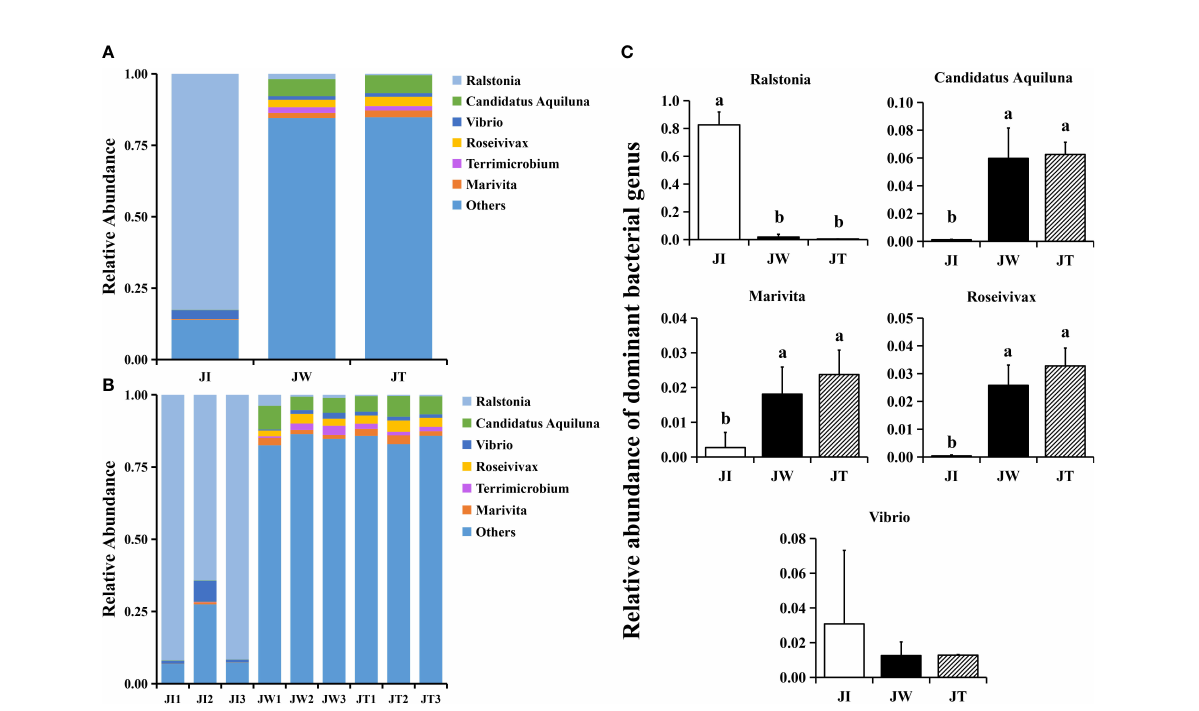
FIGURE 4 Structure and composition of the intestinal bacterial communities among shrimp intestines (JI), water (JW), and ef fl uent (JT) samples in “ Fishery- PV Integration ” ponds by genus. (A) Relative abundance of genera across the three groups, (B) the genera appearing in each sample, and (C) the changes in abundance of dominant bacterial genera. Data are presented as mean ± S.D. Dissimilar letters show signi fi cant difference ( P <